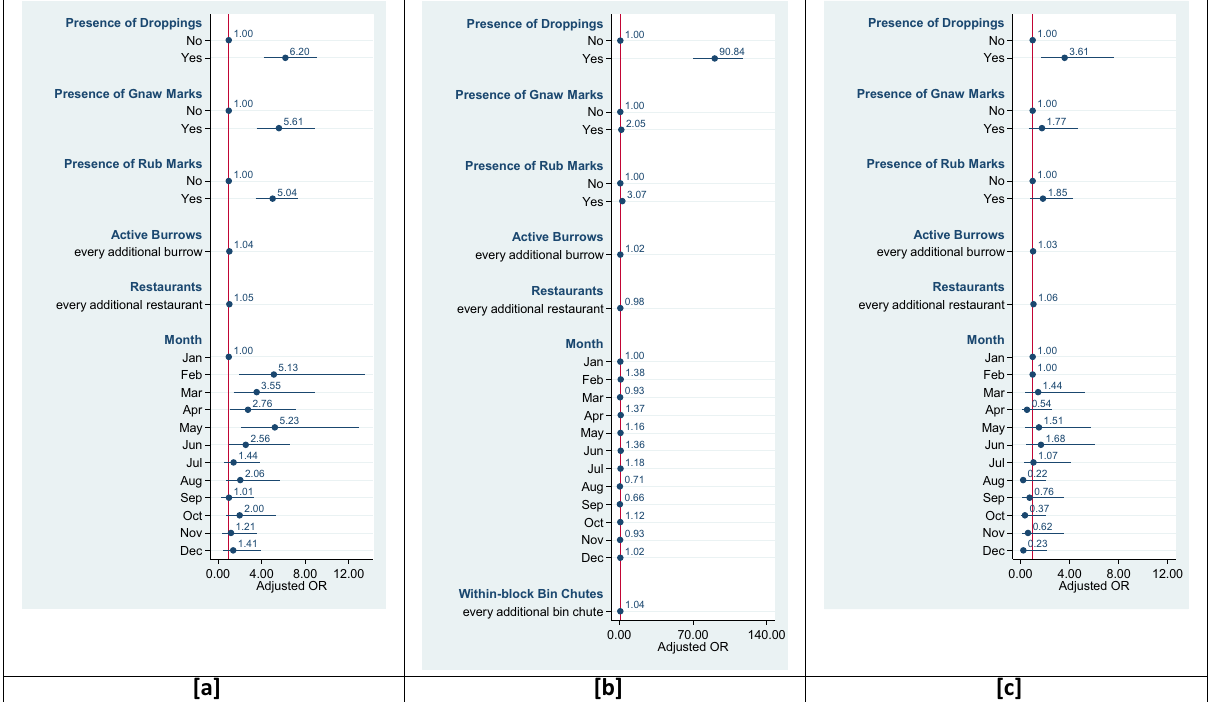
Figure 3. Adjusted ORs for factors associated with reported rodent sightings in ( a ) CRC rooms, ( b ) Individual Refuse Chute Bin Chambers and ( c ) Bin Centres. The solid circles represent the point estimates, and the horizontal navy blue lines indicate the 95% confidence intervals for those estimates. The vertical red line indicates the null value of